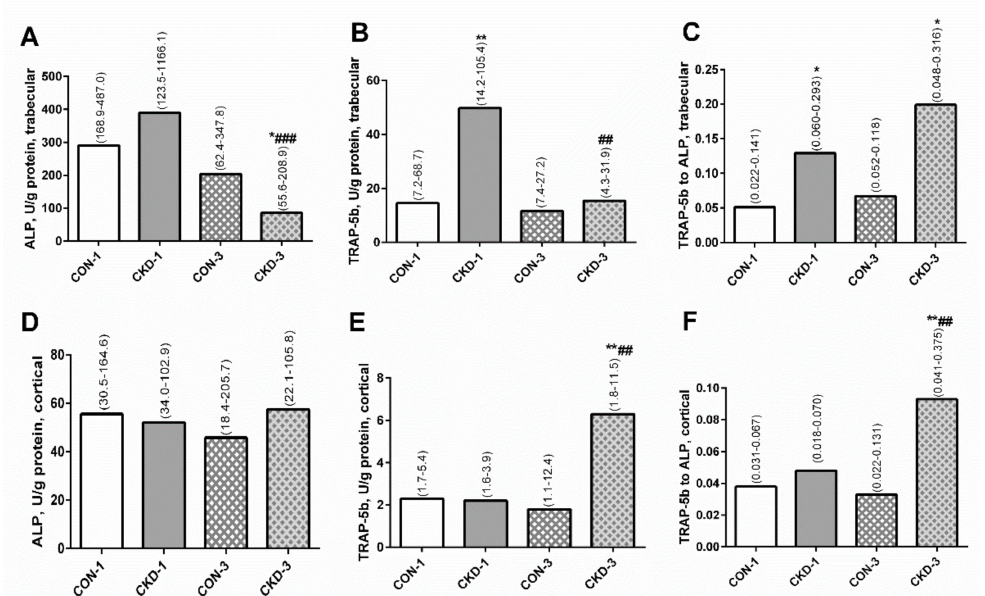
Figure 2. The bone turnover markers: ALP activity ( A,D ), TRAP-5b activity ( B,E ), and TRAP-5b to ALP ratio ( C,F ) in bone homogenates of young rats with chronic kidney disease (CKD). Data are median (full range). * p < 0.05, ** p < 0.01, controls versus appropriate CKD group; ## p < 0.01, ### p < 0.001 CKD-1 versus CKD-3; Abbreviations: ALP = alkaline phosphatase; CKD = chronic kidney disease; ; CON-1 = sham operated rats, 1 month after surgical intervention; CON-3 = sham operated rats, 3 month after surgical intervention; CKD-1 = subtotal nephrectomized rats, 1 month after surgical intervention; CKD-3 = subtotal nephrectomized rats, 3 month after surgical intervention; TRAP-5b = tartrate-resistant acid phosphatase